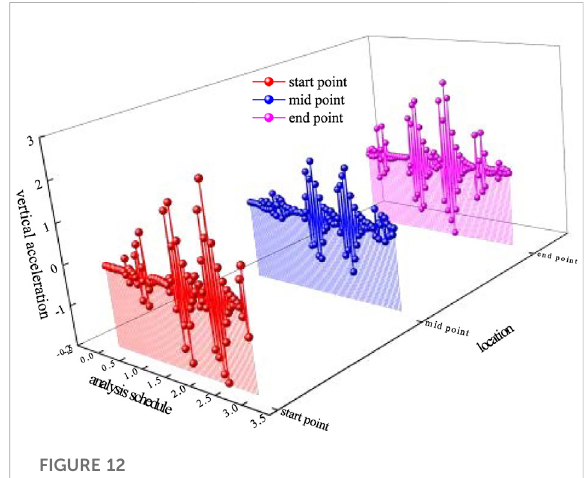
FIGURE 12 Vibration rules of vertical acceleration of feature points along different road surfaces in driving